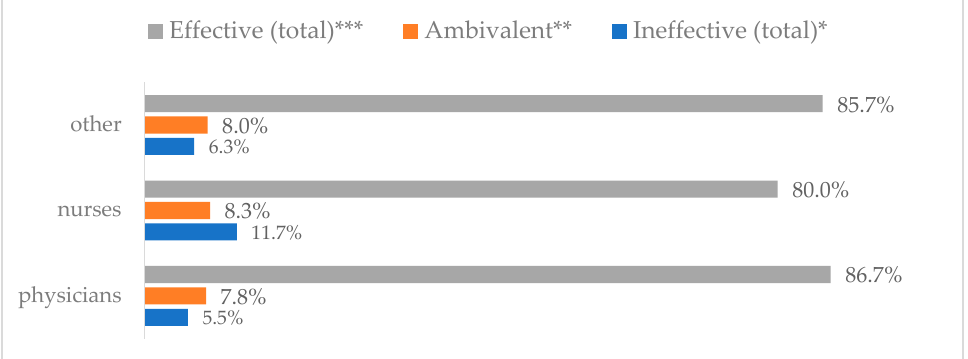
Figure 9. Hand washing to prevent influenza virus infection by profession ( N = 905). *Sum of re- sponses: completely ineffective, ineffective, rather ineffective; **Response: neither ineffective nor effective; ***Sum of responses: rather effective, effective, completely effective.